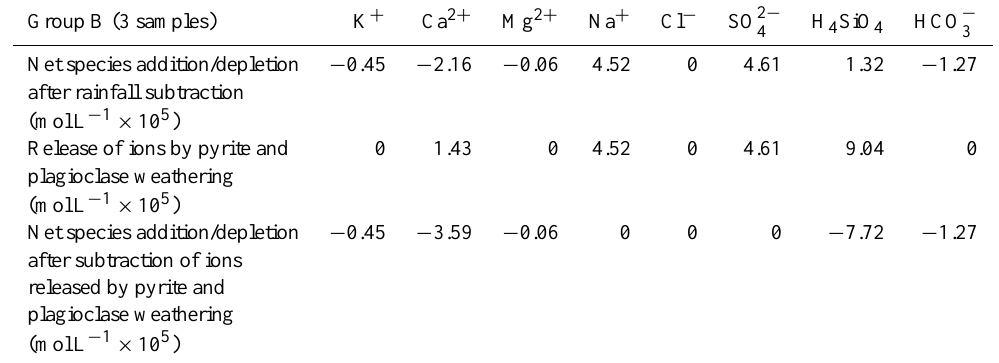
Table 7. Mass balance calculations to show influence of pyrite oxidation and plagioclase weathering on Group B groundwater composition. Group B (3 samples)